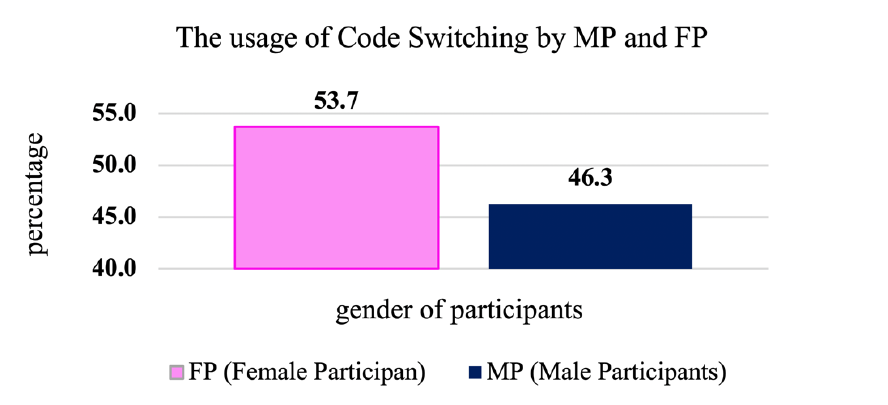
Figure 2. Percentage of using CS by MP and FP in T JA and T